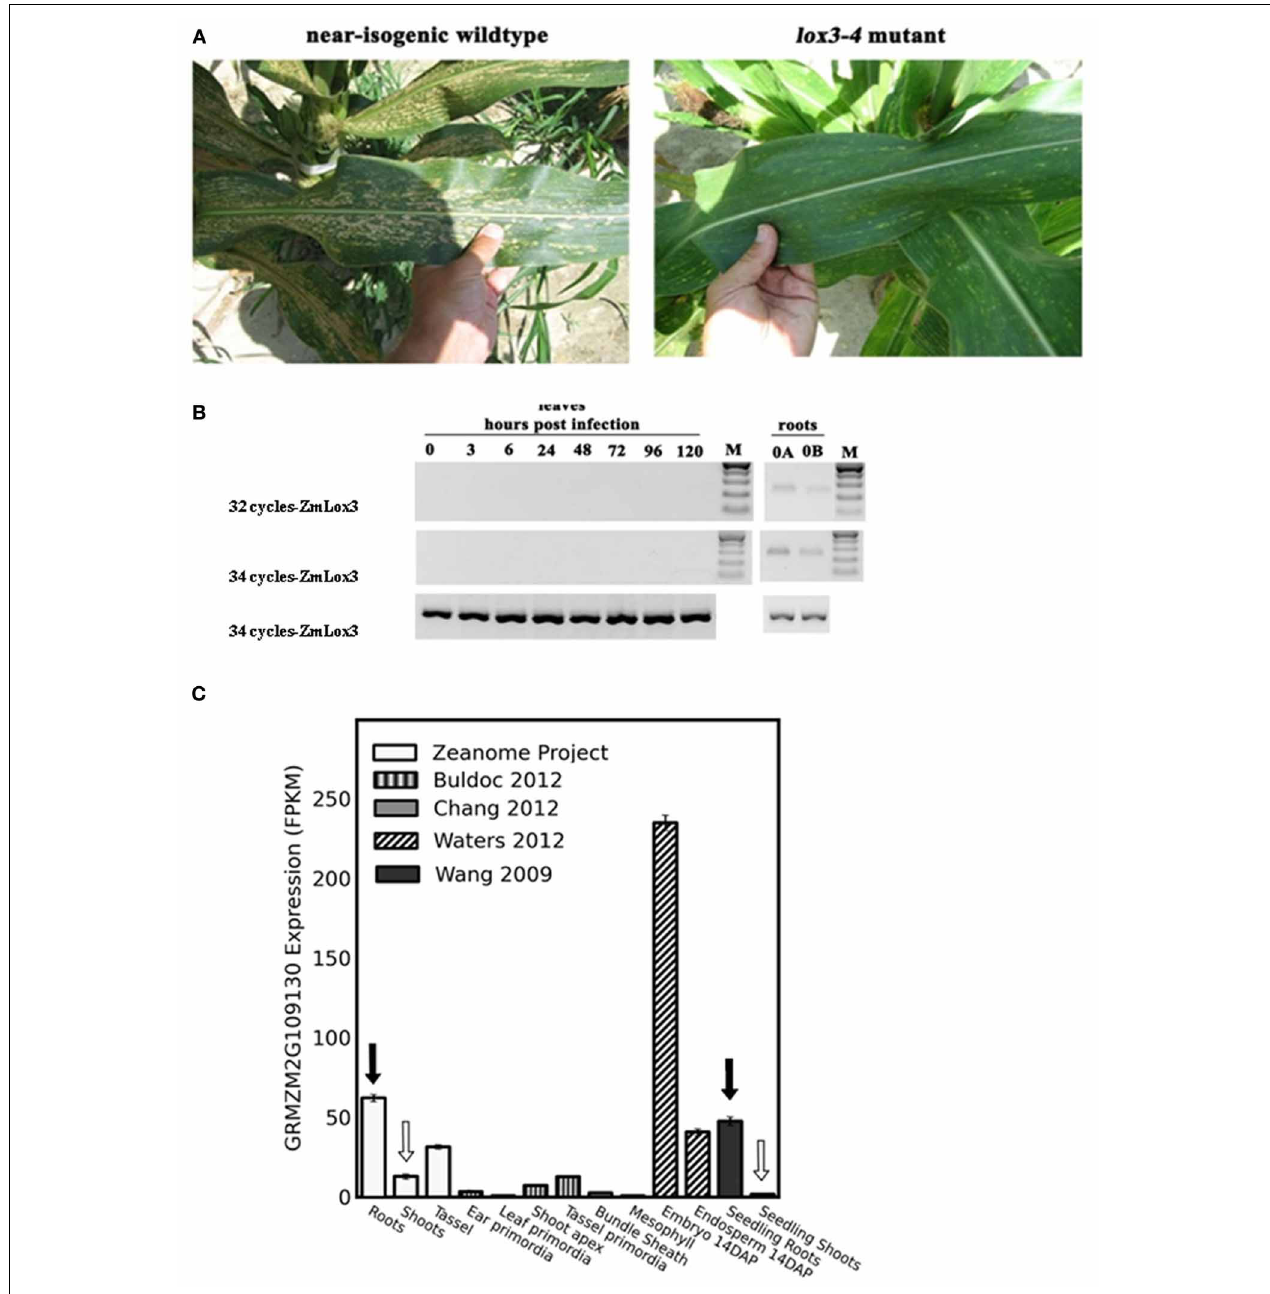
FIGURE 1 | Colletotrichum graminicola susceptibility factor, ZmLOX3 , accumulates preferentially in belowground tissue of maize. (A) Southern corn leaf blight disease symptoms observed under natural field conditions in 2006, College Station, TX, USA of lox3-4 mutant and near-isogenic wild-type maize leaves of the FR2128 background. (B) Semi-quantitative reverse-transcriptase PCR analysis of ZmLOX3 transcript